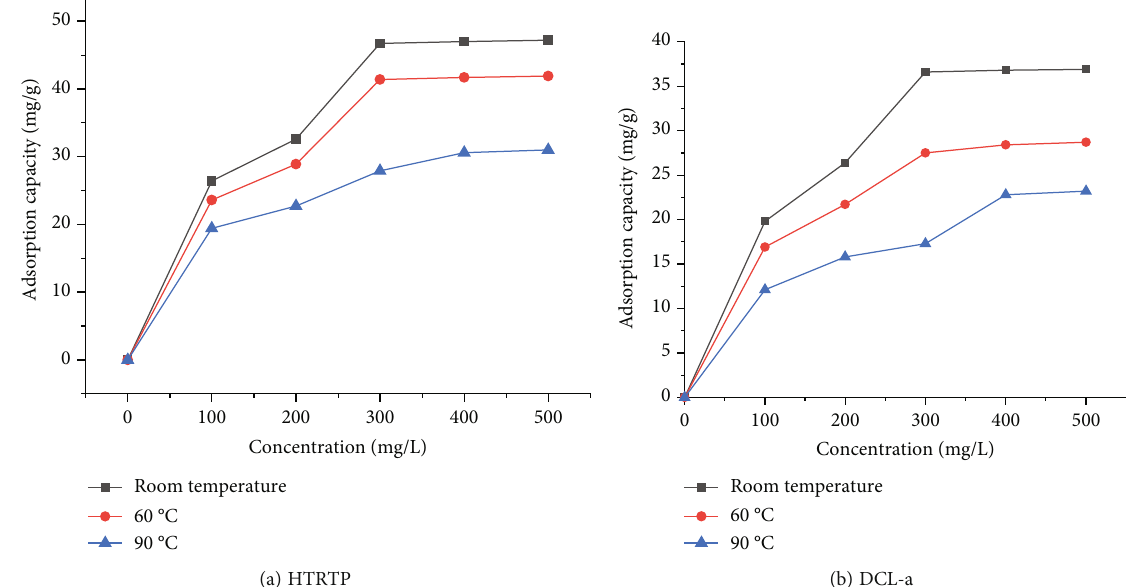
Figure 5: E ff ect of temperature on adsorption quantity of DCL-a and HTRTP.